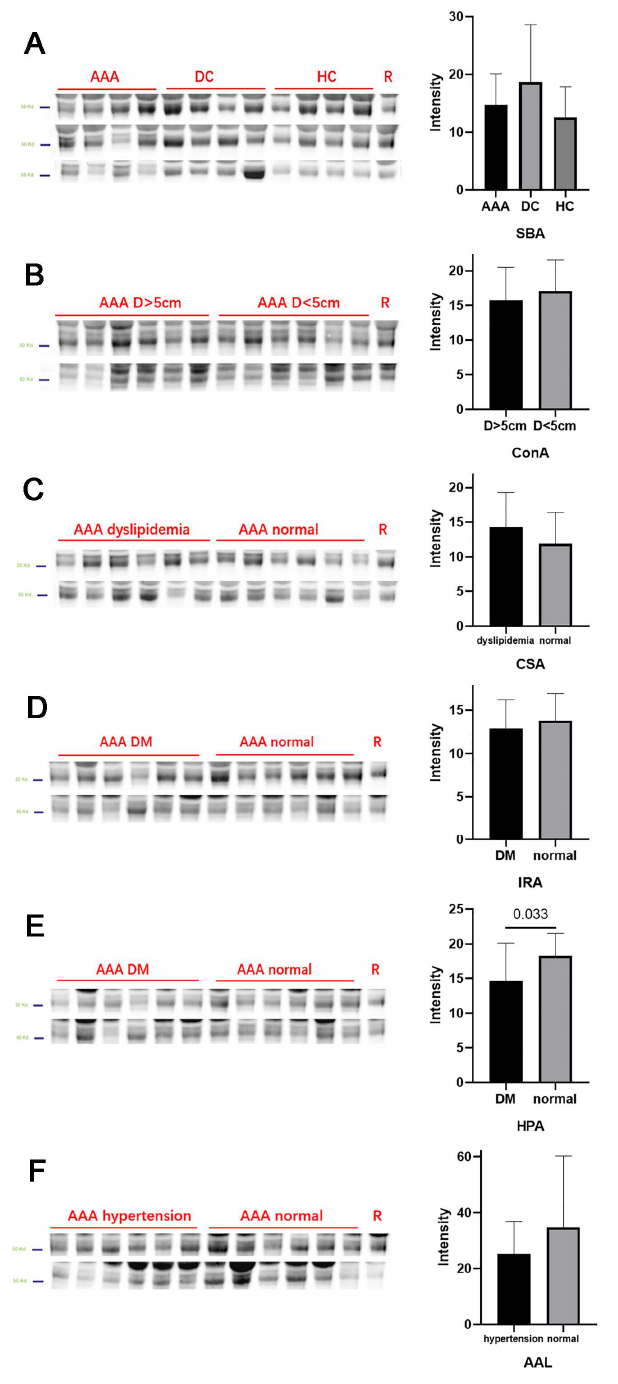
Figure 3. Lectin blot verification of microarray analysis. For each AAA subgroup, 6 old serum samples from the lectin microarray and 6 new samples were randomly selected for lectin blot. ( A ) Lectin blot result for SBA in inter-group analysis. ( B ) Lectin blot result for ConA between patients with AAA of different diameters. ( C ) Lectin blot result for CSA between AAA patients with or without dyslipidemia. ( D ) Lectin blot result for IRA between AAA patients with or without diabetes. ( E ) Lectin blot result for HPA between AAA patients with or without dyslipidemia. ( F ) Lectin blot result for AAL between AAA patients with or without